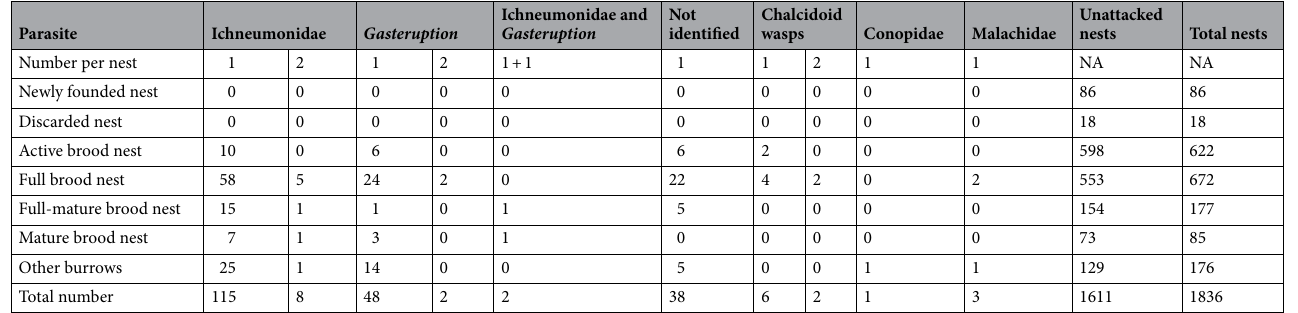
Table 4. Numbers of nests attacked by different groups of parasites. Ichneumonidae or Gasteruption young larvae were not always undistinguished. These parasites are in column not